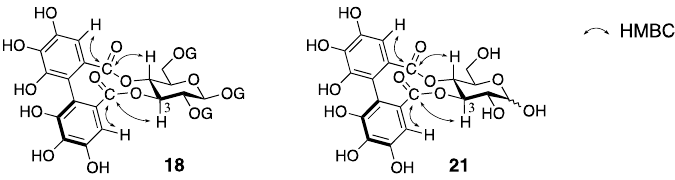
Figure 12. The significant HMBC relationships used for the determination of the structure 18 and 21 .